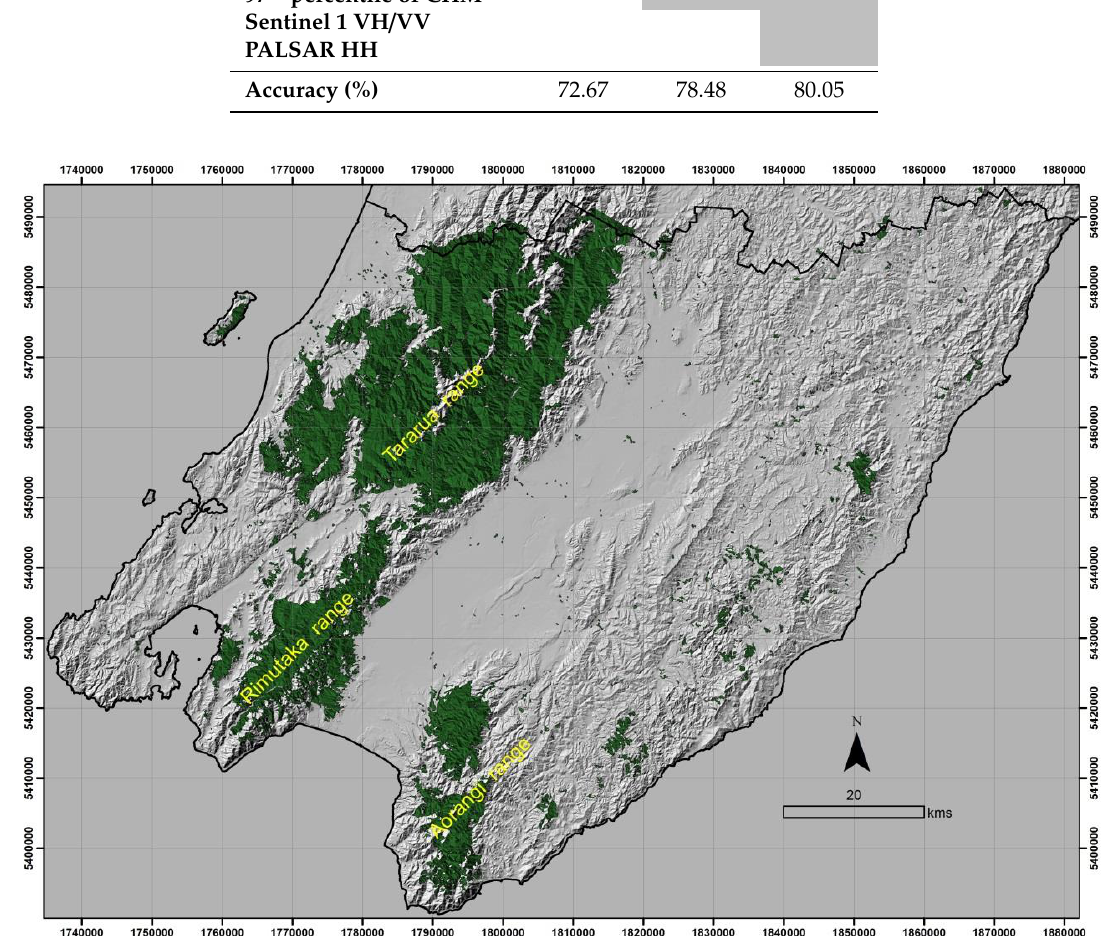
Figure 1. Map of Wellington region showing areal extent of indigenous forest in dark green. Indigenous forest occurs primarily in the Taraua, Rimutaka, and Aorangi mountain ranges. Map grid is the New Zealand Transverse Mercator.